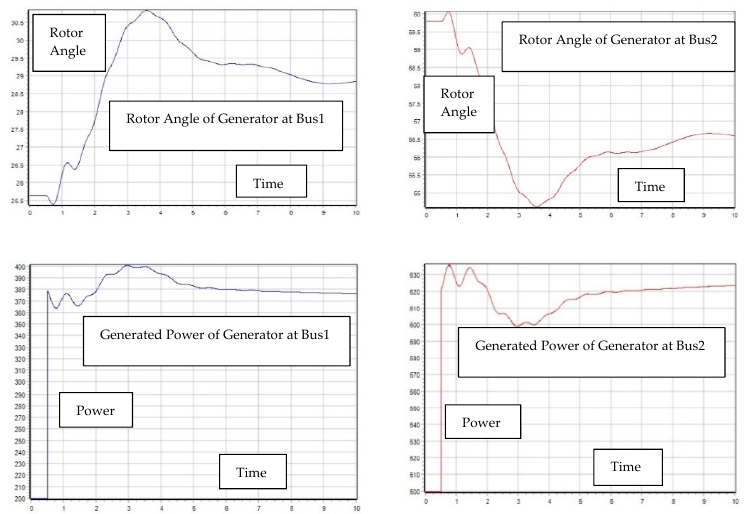
with respect to time and then reaches to an equilibrium point for maintaining system sta- bility. The rotor angle follows the generated power according to the swing equation of Figure 11. Fluctuation of bus voltage due to sudden increment of load at buses 5 and 7. synchronous machine.